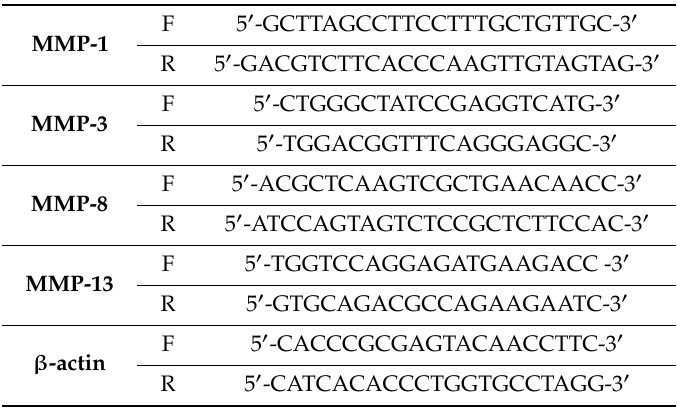
Table 1. Sequences of mRNA primers used in knee cartilage